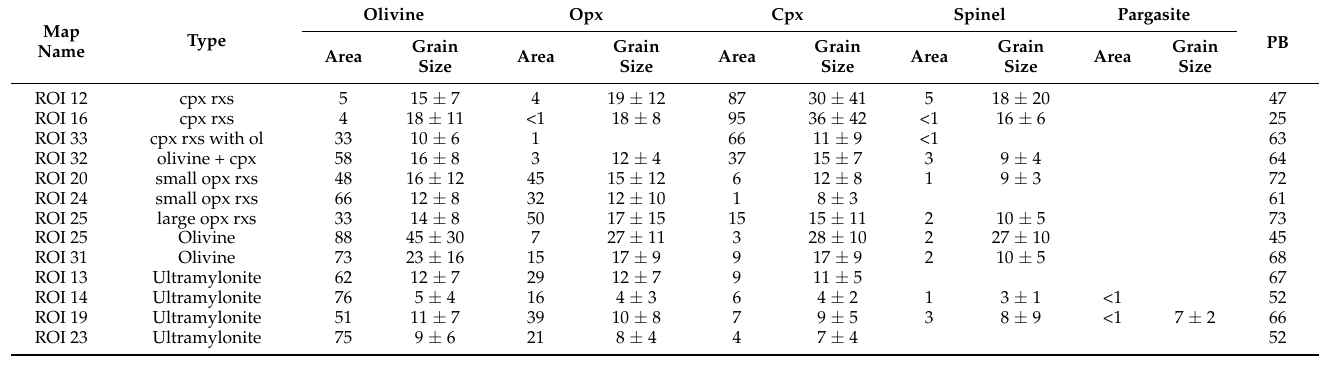
Table 1. Area percentages and grain sizes ( µ m), with the standard deviation, of all analyzed phases. The last column shows the proportion of phase boundaries (PB) of the total boundary length as a percentage.